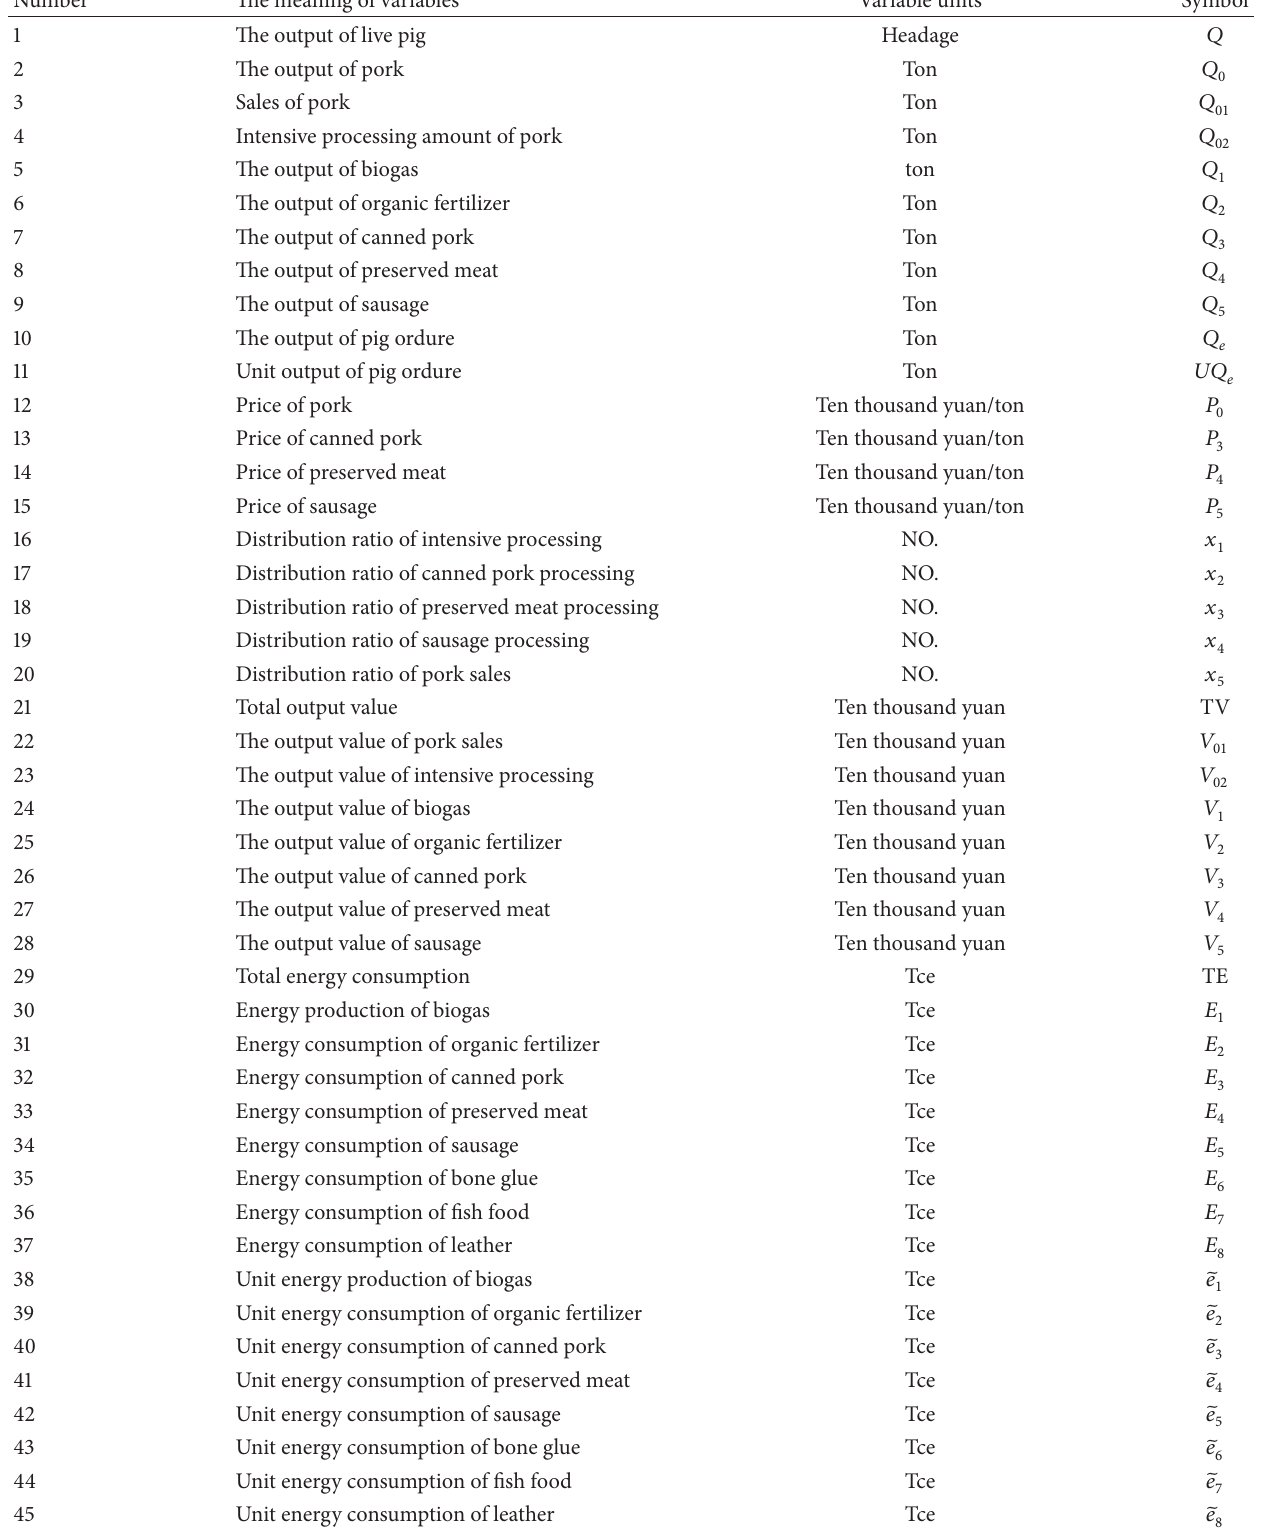
Table 1: Variable symbol of pig industry